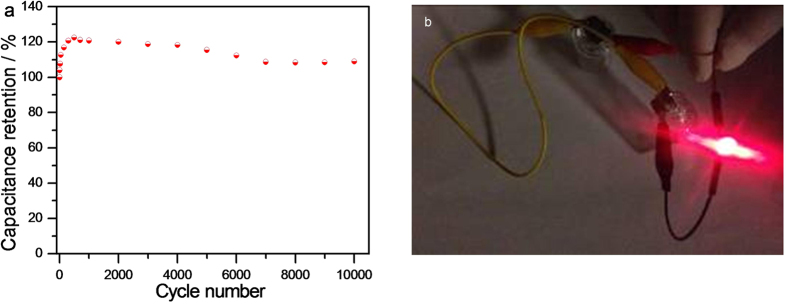
(a) Cycling stability for GOMC//Ni50Co50-LDH device; (b) A red LED (1.5 V) was powered by the device.